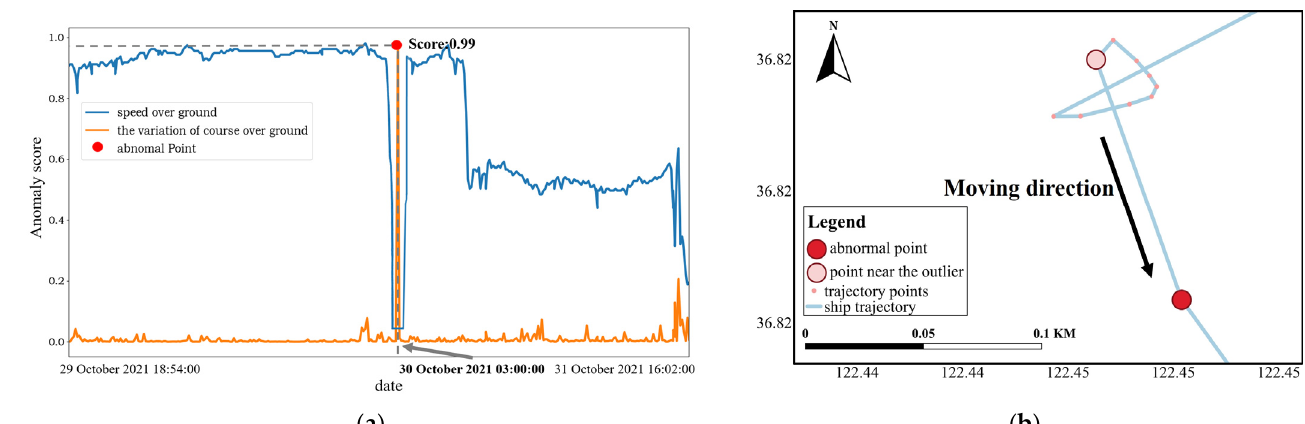
Figure 16. Spatial distribution of abnormal ship behavior detection scores based on combined thematic attributes. ( a ) The spatial distribution of the anomaly detection results when the combined thematic attribute features were the speed over ground and the variation of the course over ground. ( b ) The spatial distribution of the anomaly detection results when the combined thematic attribute features were the average velocity and average acceleration.